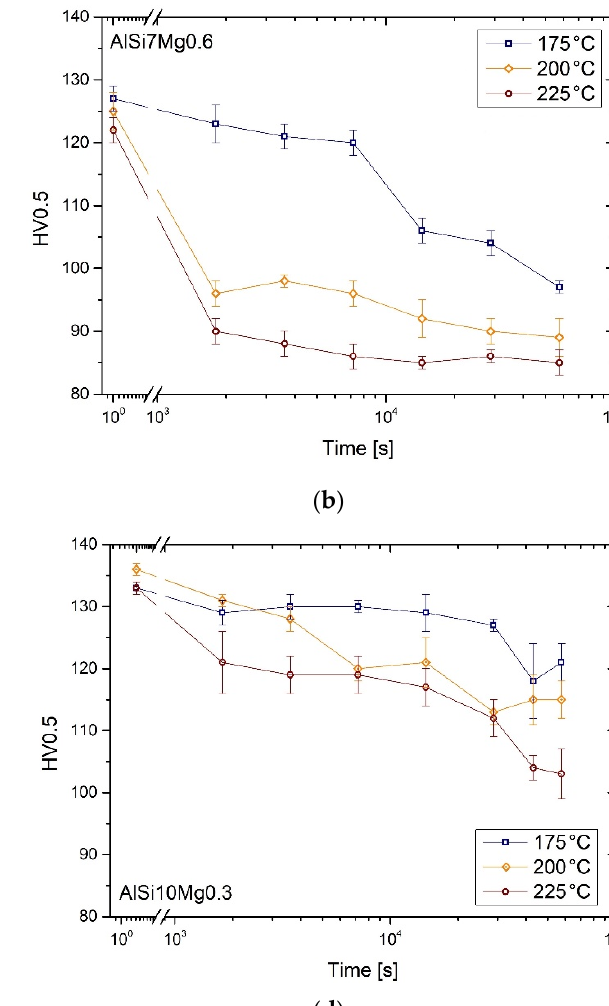
Figure 10. Aging curves of the top ( a , c ) and bottom ( b , d ) samples of the AlSi7Mg0.6 ( a , b ) and AlSi10Mg0.3 ( c , d ) alloys direct aged at 175 ◦ C, 200 ◦ C and 225 ◦ C. The as-built conditions are considered at time equal to 1, and not to 0, because the time-axes are in log